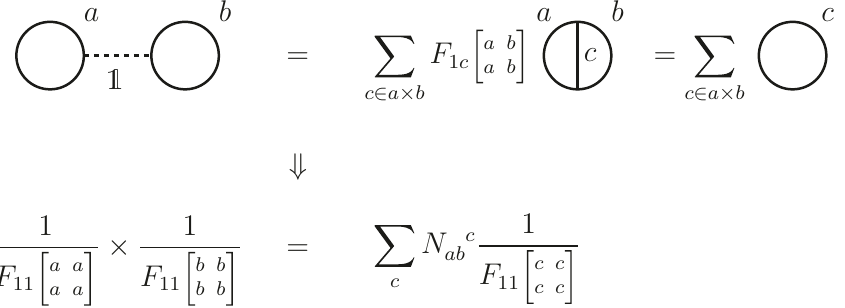
Figure 6 . Defect sunset network gives rise to an S 3 symmetric factor θ ( a, b, c ).